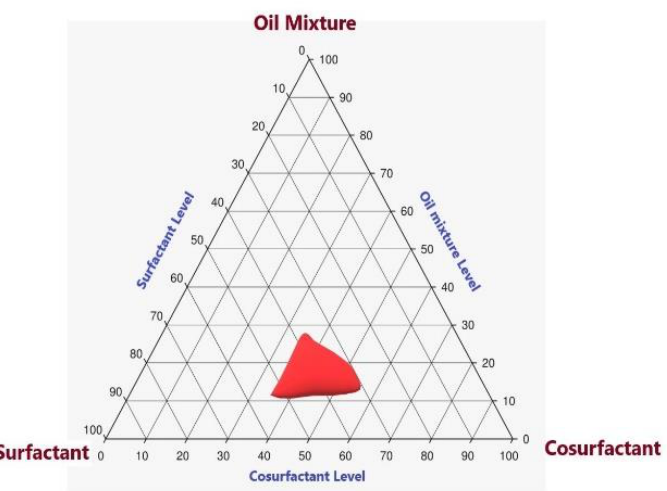
Figure 2. The pseudoternary-phase diagram of Eu oil/Maisine mixture, surfactant (TPGS), and co-surfactant (propylene glycol).